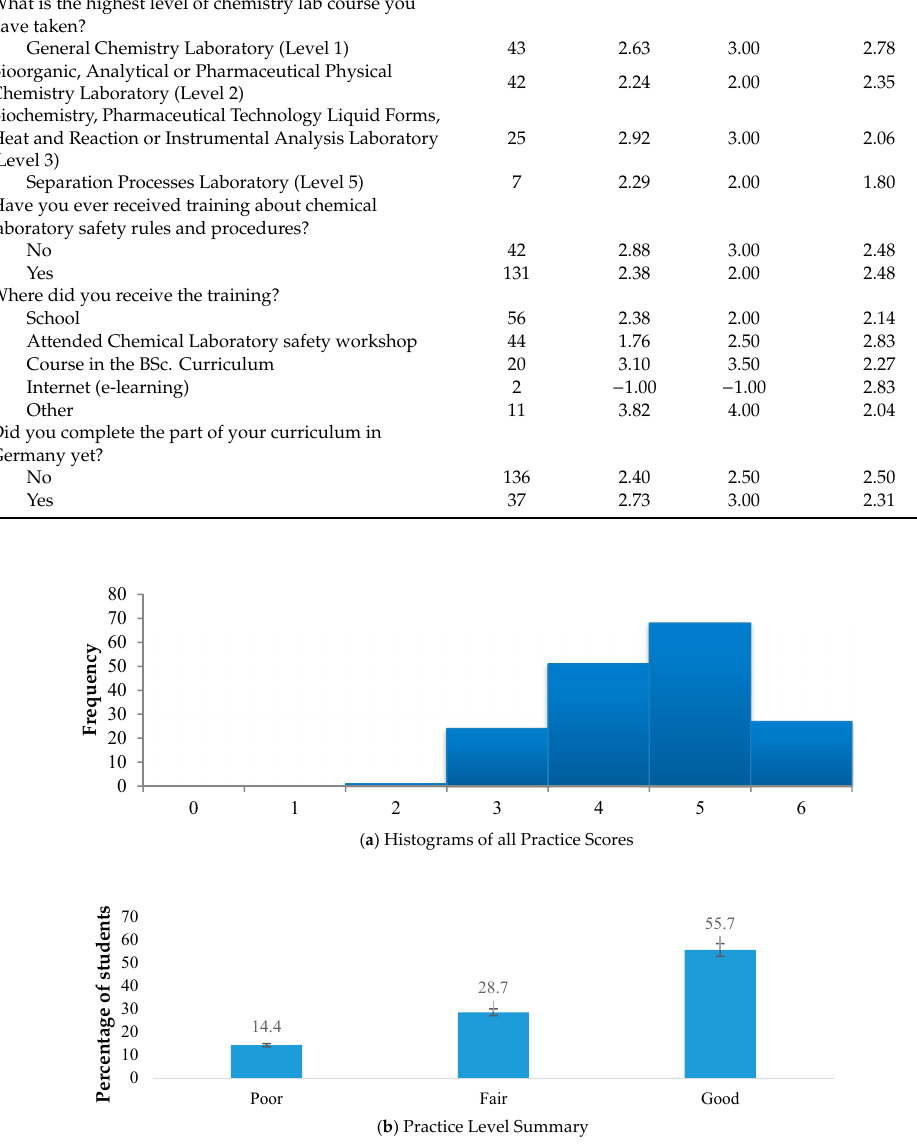
Figure 3. Chemical Laboratory Safety Practices adopted by students.